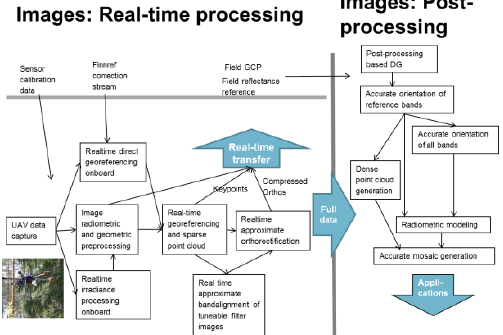
Figure 2. Real-time and post-processing chains for image based drone